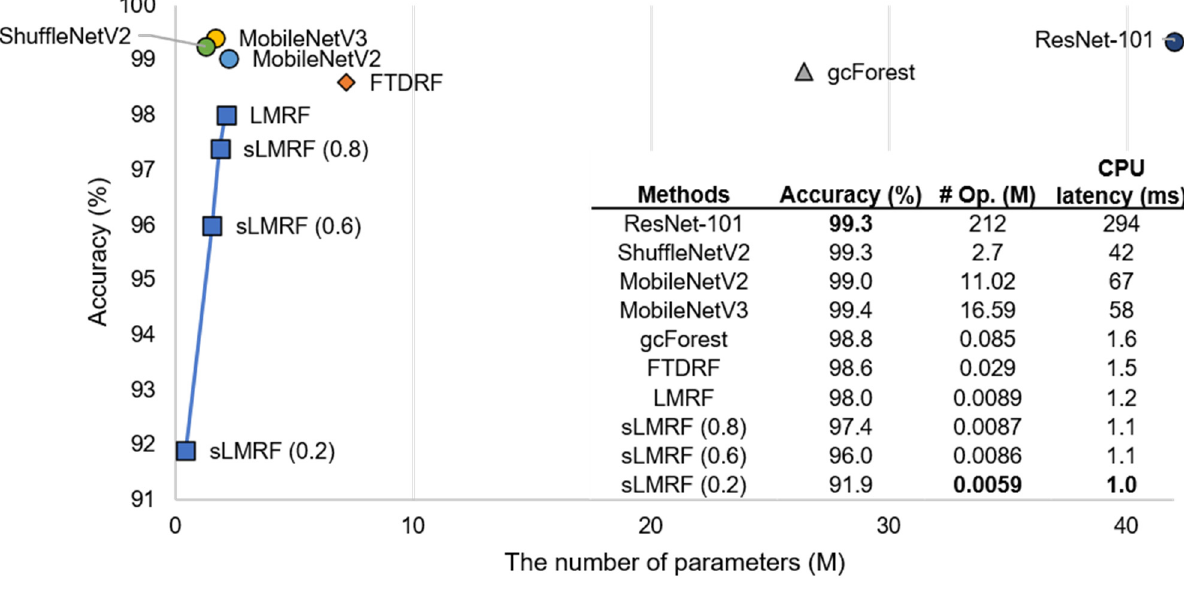
Figure 4. Comparison of accuracy, numbers of parameters (# Param.), numbers of operations (#Op.) and CPU latency with the state-of-the-art methods using the MNIST dataset.